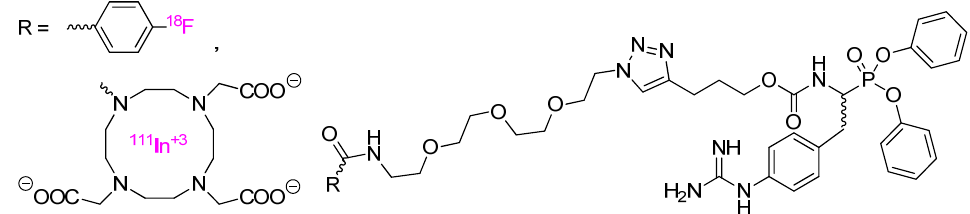
Figure 4. Radiolabelled activity-based probes for imaging in positron emission tomography or single photon emission computed tomography, based on the structure of p -guanidino-PheP(OPh) 2 , an inhibitor of urokinase-type plasminogen